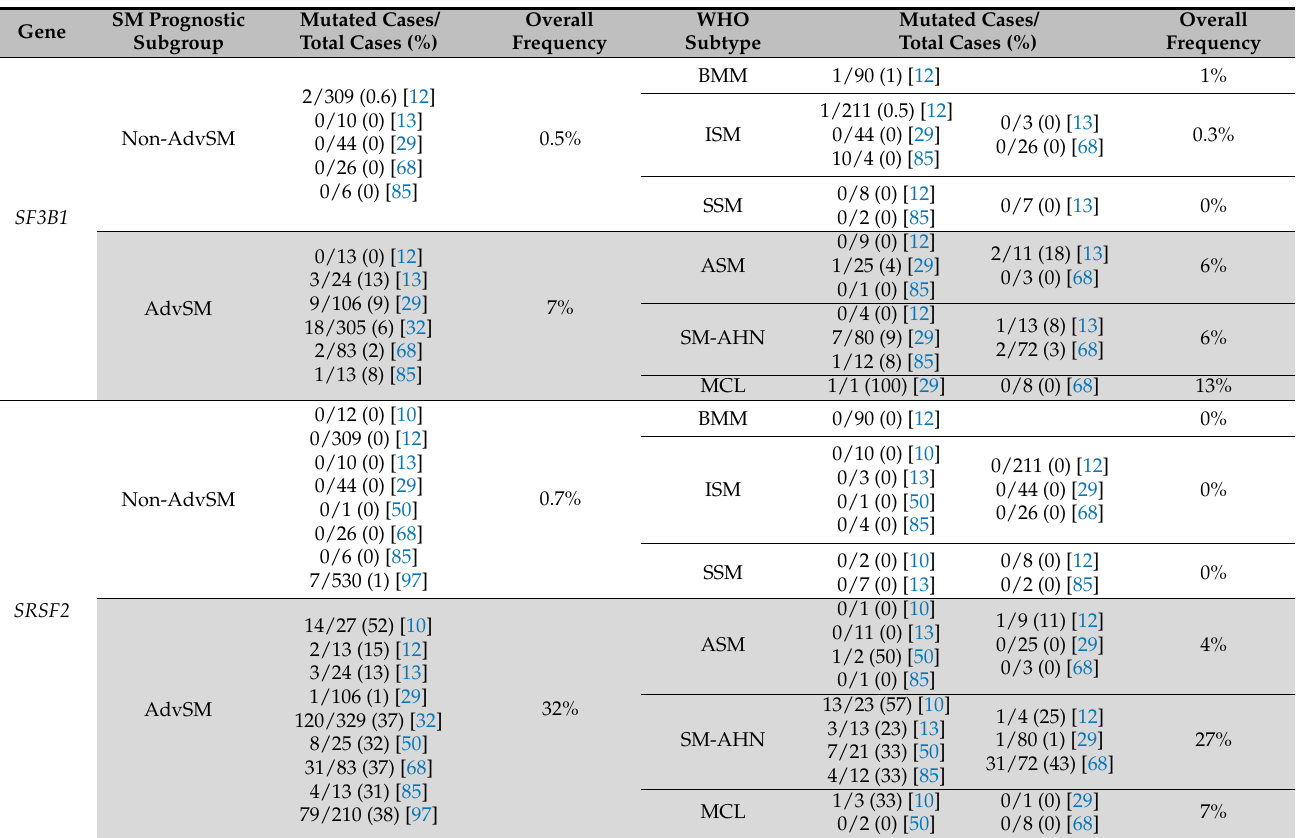
Table 5. Frequency of mutations in genes involved in alternative mRNA splicing recurrently found in systemic